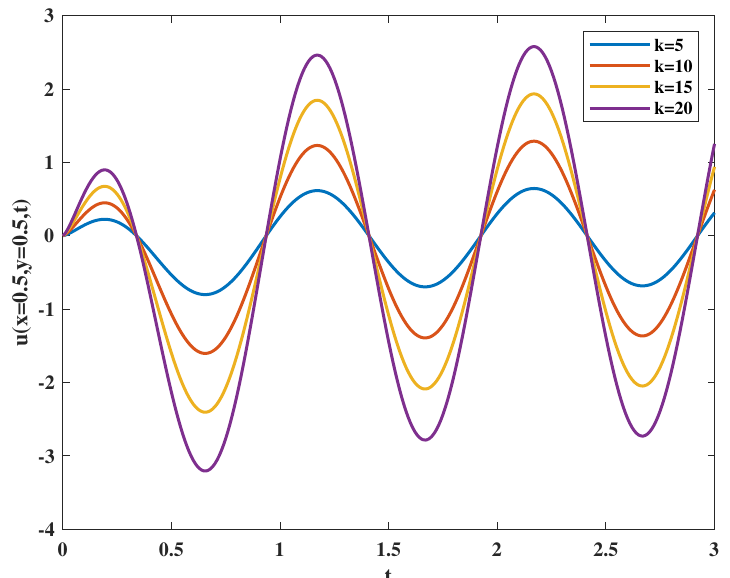
Figure 1. Velocity varies with amplitude of pressure gradient k .